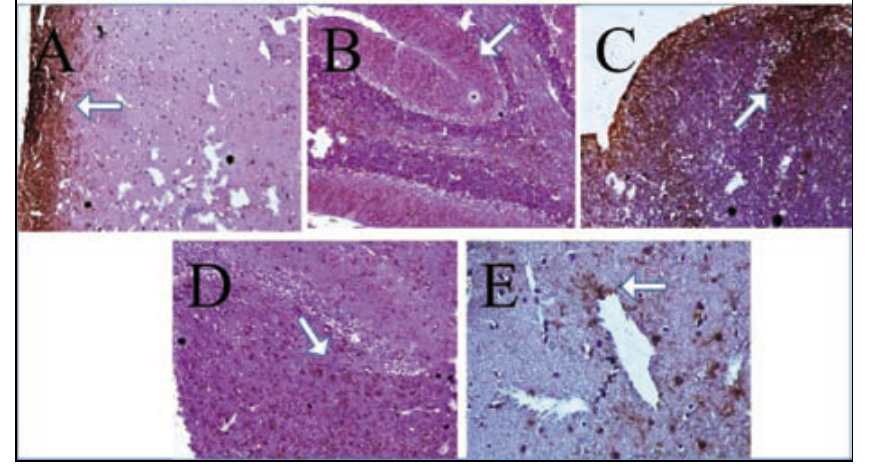
Fig. 1. GFAP reactivity in furious form of rabies (100X; DAB stained IHC sections counter stained by Heamatoxylin) A: Cerebrum- hypertrophy of astrocytes in glial limitans; B: Cerebellum- Astogliosis of white matter and extension of processes to the grey matter; C: Brainstem- astrogliosis; D: Hippocampus- astrocytosis near the dentate gyrus and E: Around the blood vessels in hippocampus(400X)